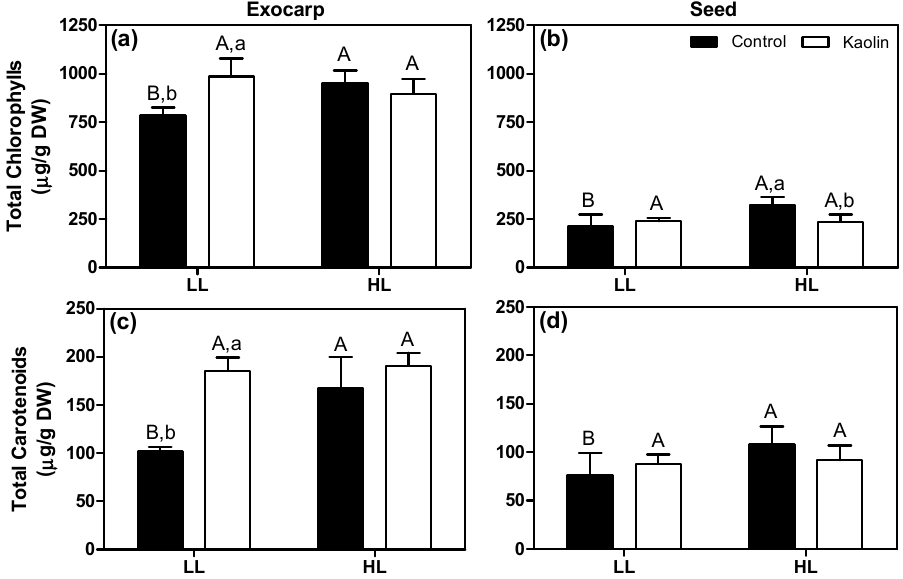
Figure 8. Chlorophylls ( a,b ) and carotenoids ( c,d ) concentration mean values ( n = 3, + SD) of exocarps and seeds obtained from LL and HL grape berries grown under non-kaolin (black columns) and kaolin (white columns) application, and collected at the green stage. Statistical notation: di ff erent capital letters refer to significant di ff erences (two-way ANOVA, p ≤ 0.05) between the two light microclimates within the same plant treatment, and di ff erent lowercase letters to di ff erences between treatments within each light microclimate. If the respective factor did not have a significant e ff ect, the letters were omitted.